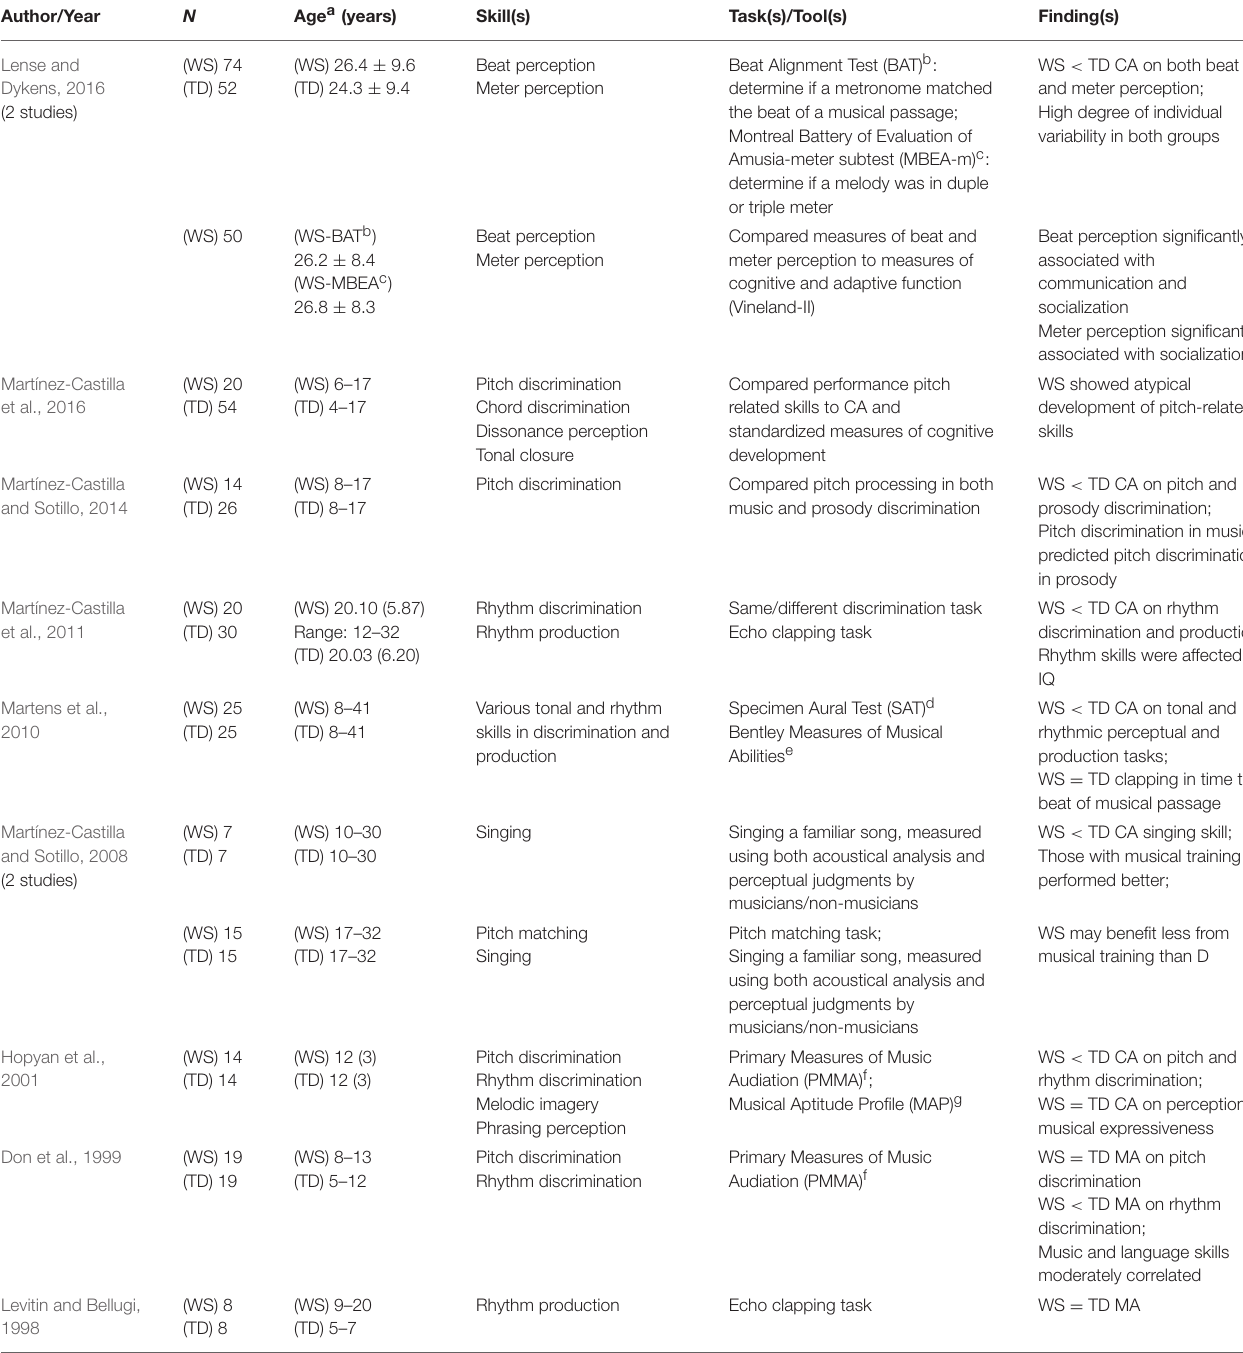
TABLE 3 | Musical skill: tonal and rhythmic